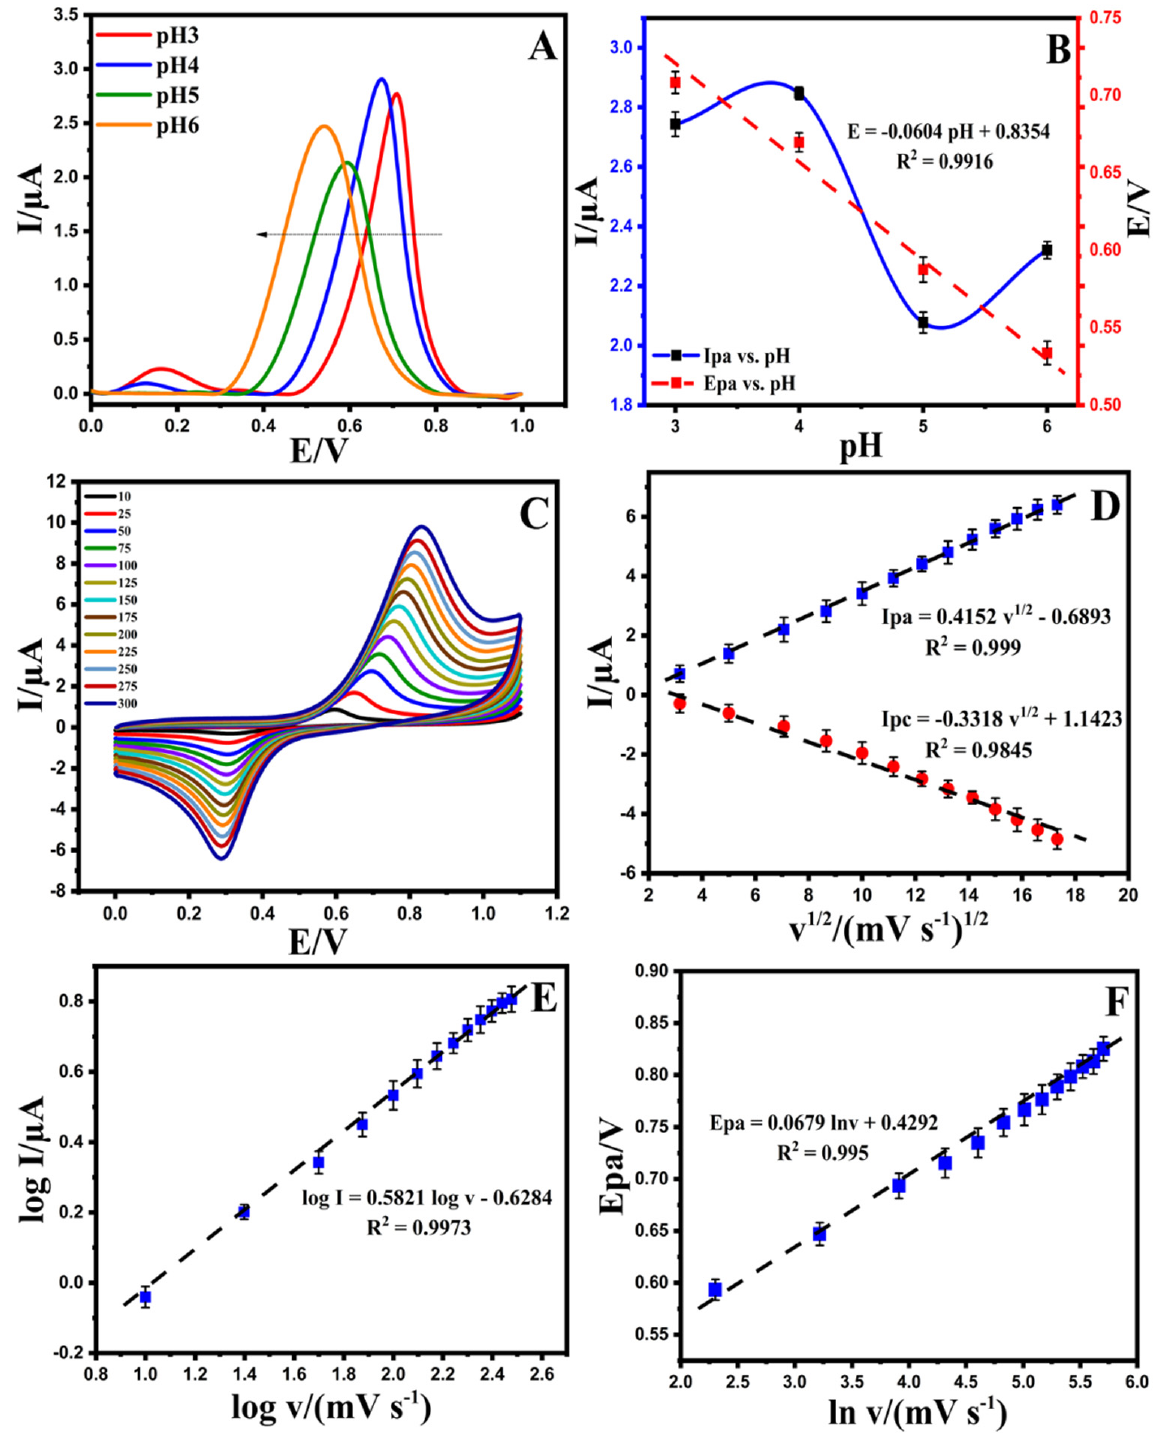
Figure 4. ( A ); Differential pulse voltammetry solution containing 5.0 µM EPR in the pH range of 3.0–6.0 at the Au@NiFe 2 O 4 /SPE, ( B ); Effect of pH values on the peak current (blue line) and peak potential (red line) of EPR on the surface of the Au@NiFe 2 O 4 /SPE at various pH values (from 2.0 to 8.0), ( C ); Cyclic voltammograms solution containing 5.0 µM EPR in the B-R buffer at pH 4.0 at di- verse scan rate (10–300 mV s − 1 ), ( D ); The plot of I (pa,pc) vs. ν 1/2 for 5.0 µM EPR on the surface of